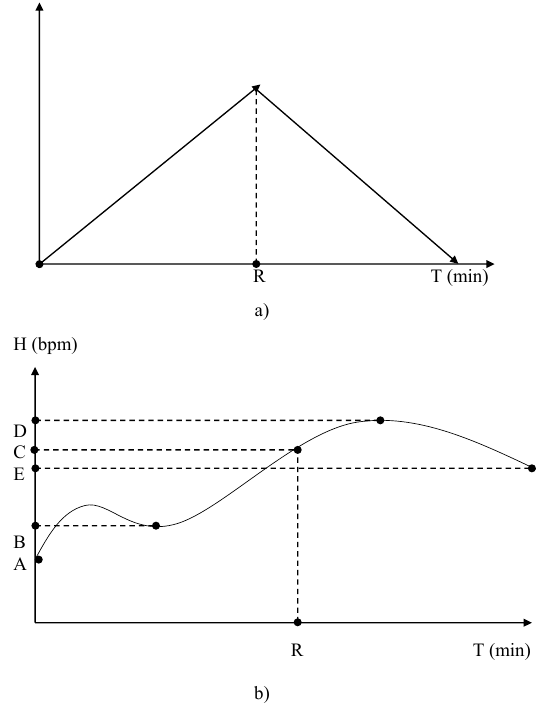
Fig.1. Dynamic of stationary bicycle load (upper part of figure) and heart beats rate changes during test (lower part of figure): W – power of load; R – power of load at reverse; Т – time of testing; Н – heart beats rate